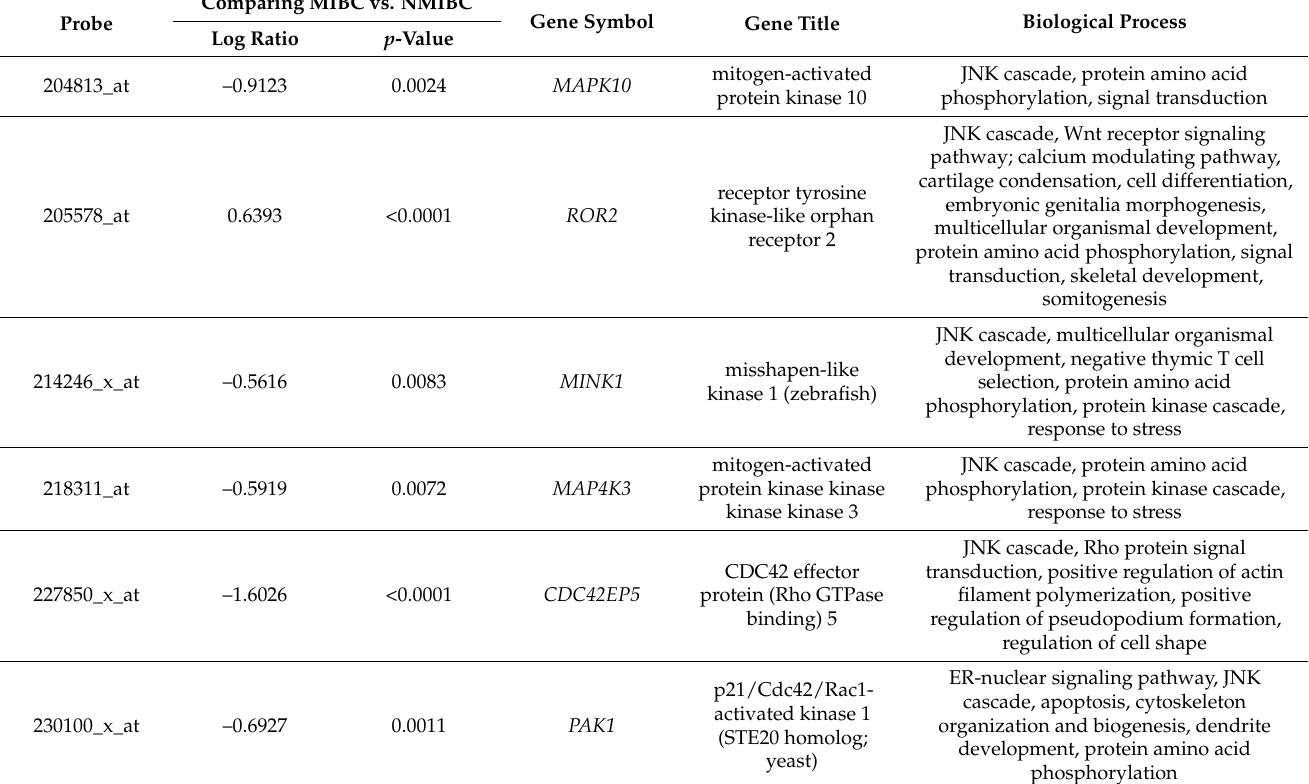
Figure 2. Expression of ROR2 mRNA and protein in urothelial carcinoma specimens. ( A ) ROR2 mRNA level was significantly increased in MIBC (pT2-T4) using qRT-PCR. ( B ) Invasive UC showed high ROR2 expression using immunohis- tochemistry (normal urothelium in the inset) (magnification × 2000). Table 1. The top six significantly dysregulated genes belonging to the JNK cascade are associated with muscle invasion in UBUC (GSE31684).